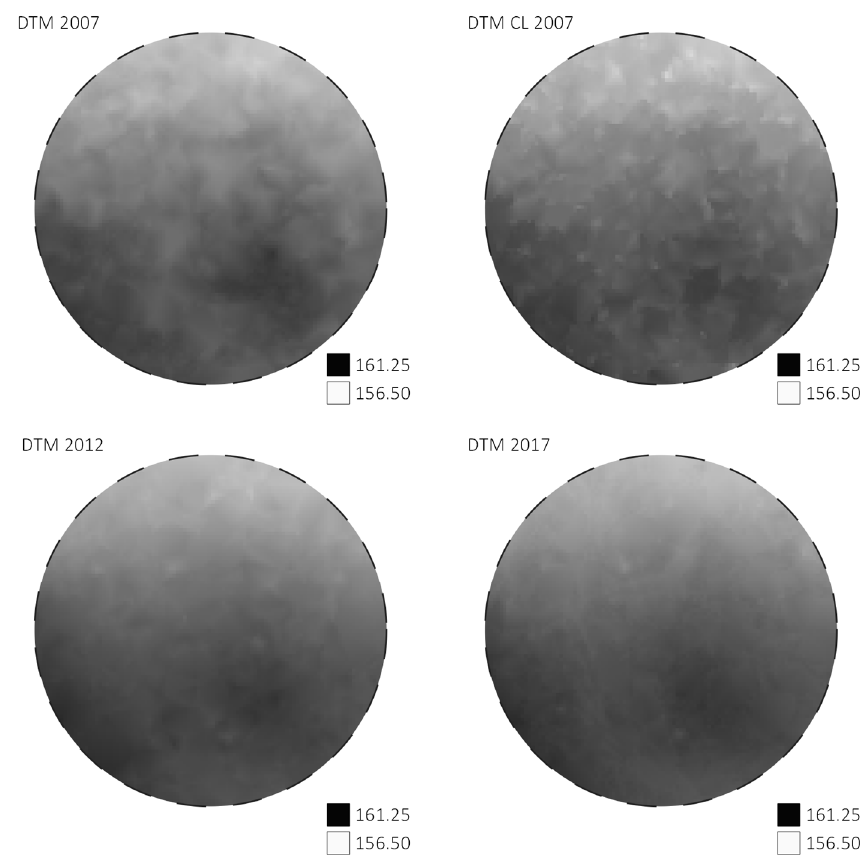
Figure 4. An example of 4 versions of digital terrain models (DTM) for the same circular sample plot (SP).